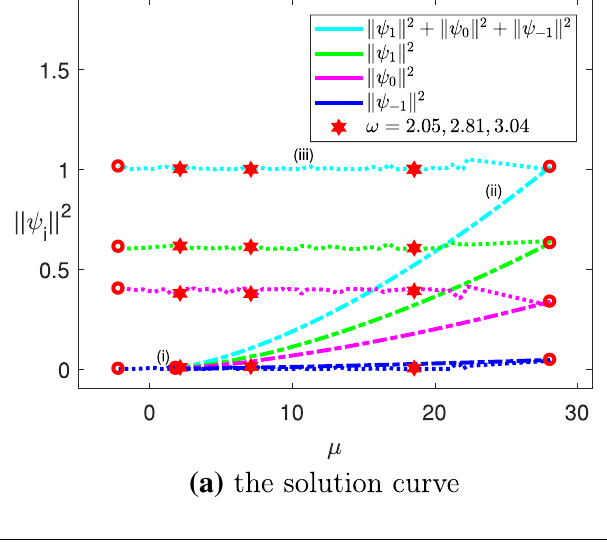
6000 , and ω 0.6 , N = = (cid:31)